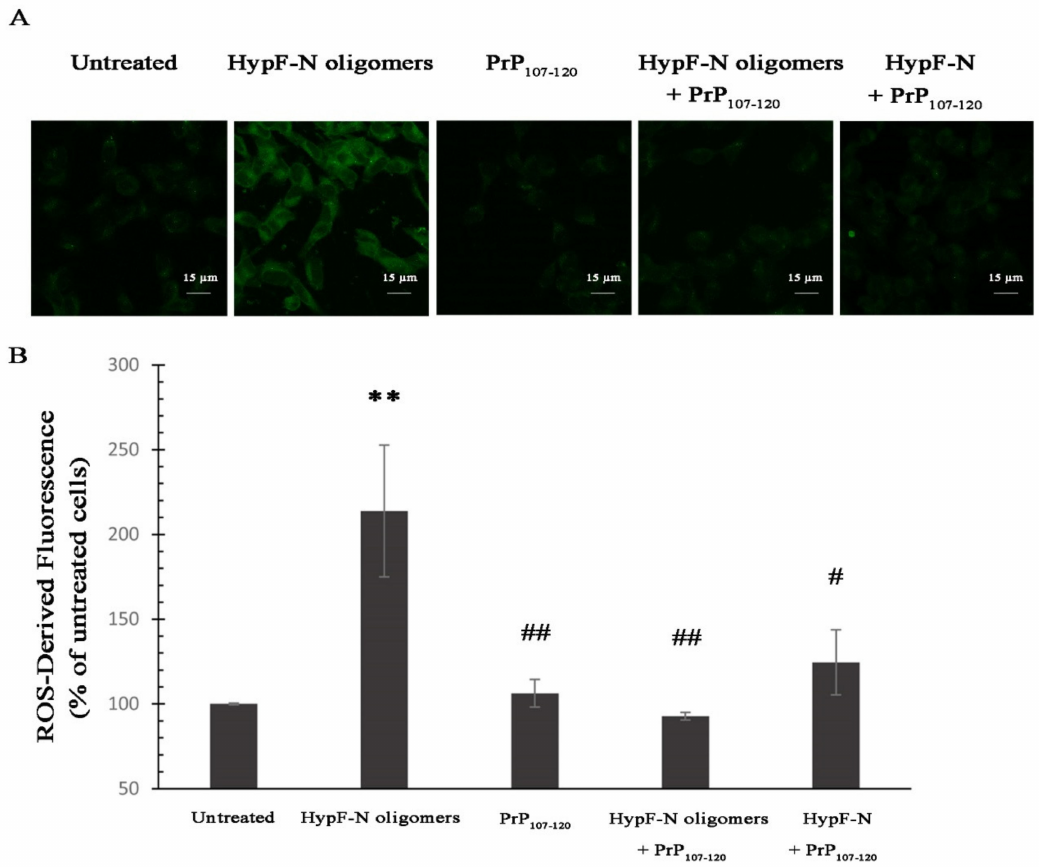
Figure 6. Analysis of intracellular ROS levels of SH-SY5Y cells treated with type A HypF-N oligomers and PrP 107–120 . ( A ) Representative scanning confocal microscopy images of intracellular free ROS levels in SH-SY5Y cells loaded with CM-H 2 DCFDA. The cells were treated for 1 h with HypF-N oligomers, PrP 107–120 , HypF-N oligomers + PrP 107-120 and a sample containing HypF-N and PrP 107–120 pre-incubated under conditions promoting HypF-N oligomer formation prior to addition to the cell medium. Final HypF-N and PrP 107–120 concentrations were 12 and 3 µ M (m.e.), respectively. Scale bar = 15 µ m. ( B ) Semi-quantitative analysis of intracellular ROS-derived fluorescence. Experimental errors are S.E.M. ( n = 3). The double (**) asterisks refer to p values < 0.01 relative to the untreated cells. The double (##) and single (#) symbols refer to p values < 0.01 and < 0.05, respectively, relative to HypF-N